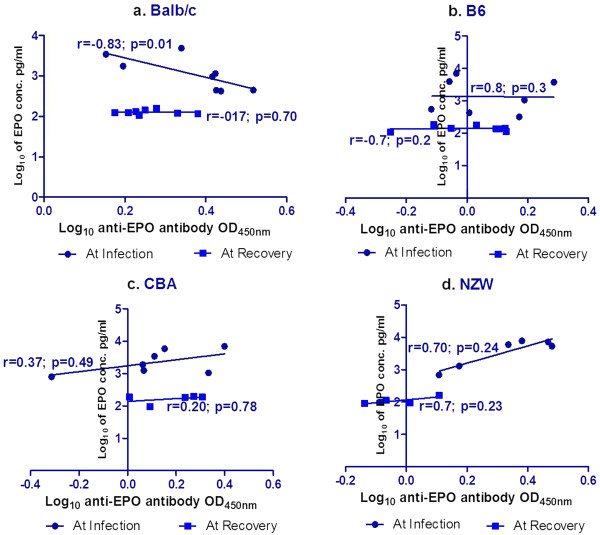
Correlation between EPO and anti-EPO antibody at infection and recovery of all the semi-immune mice strains. Blood was harvested for serum at minimum Hb at infection and at recovery for EPO and anti-EPO antibody measurement as indicated in materials and methods. Number (n) of mice per strain at infection, Balb/c (n = 8), B6 (n = 7), CBA (n = 7) and NZW, (n = 6); and at recovery, Balb/c (n = 8), B6 (n = 8), CBA (n = 5) and NZW (n = 5)). Graph a. upper left is correlation for Balb/c; graph b. upper right is correlation for B6; graph c. lower left is correlation for CBA; graph d. is correlation for NZW. Continues line is the line of best fit, while r is Pearson coefficient. These are pooled data of two experiments. Log10 transformation of EPO was done on the EPO concentration of pg/ml after being converted from OD values from the ELISA readings. Anti-EPO antibody values (OD values) were also log10 transformed.